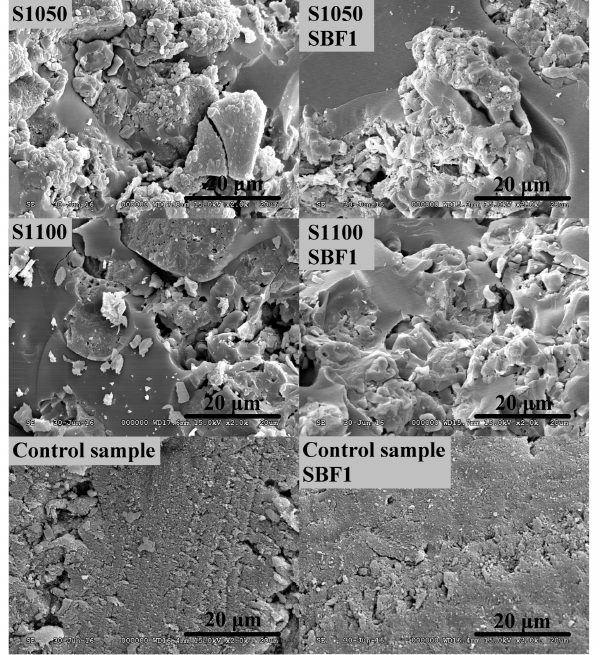
Figure 3. SEM micrographs of the samples calcined at 1050 ◦ C (S1050) and 1100 ◦ C (S1100) and the control sample. There was no hydroxyapatite deposition on the surfaces of the samples. The scanning electron micrographs of S1050, S1100, and of the control samples treated in SBF2, SBF3, and SBF4 are shown in the Supplementary Materials (Figures